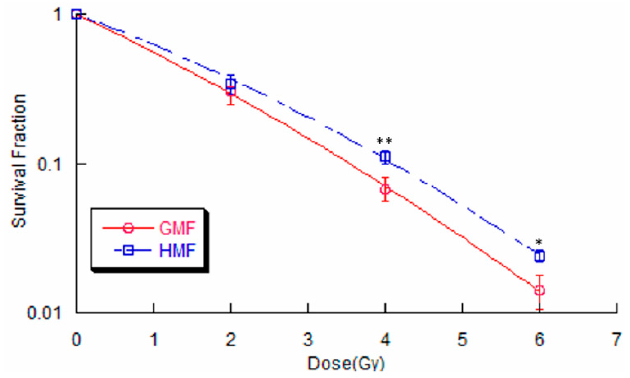
Figure 2. Survival curves of BEAS-2B cells irradiated by a series doses of X-ray under HMF or GMF conditions. Experimental data represent the mean of three paralleled samples from three independent experiments. (* p < 0.05, ** p < 0.01 compared with the GMF group, ANOVA).